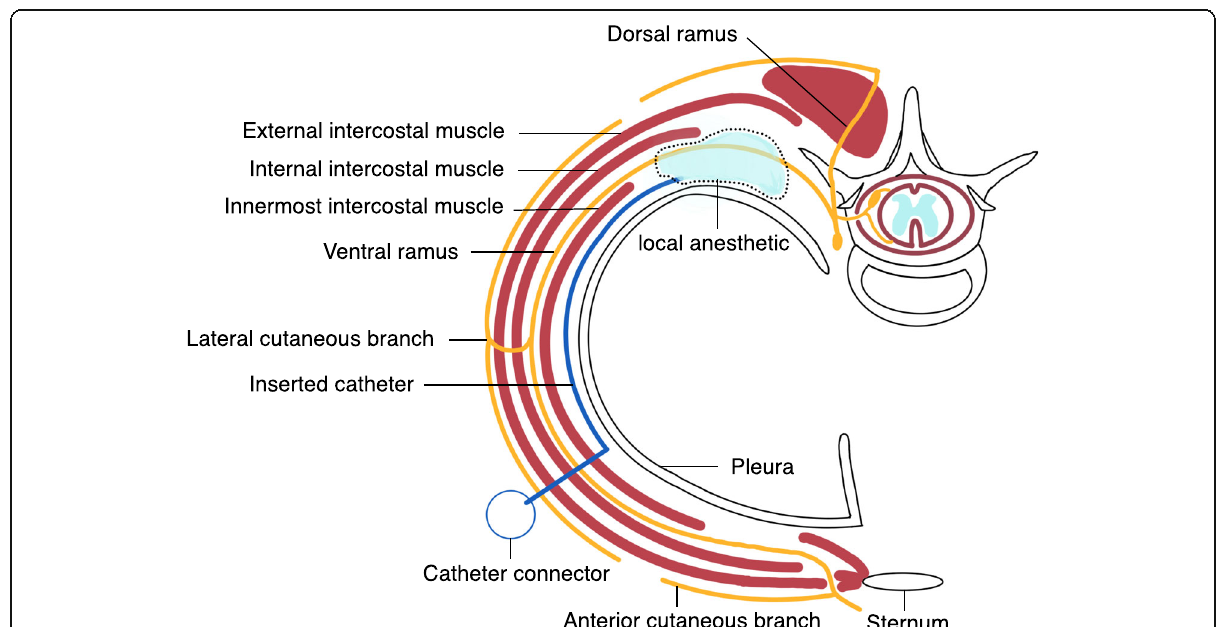
Fig. 1 Schematic drawing of the continuous modified intercostal nerve block and the spread of solution. The catheter was inserted from the outer edge of the incision and placed between the innermost intercostal muscle and parietal